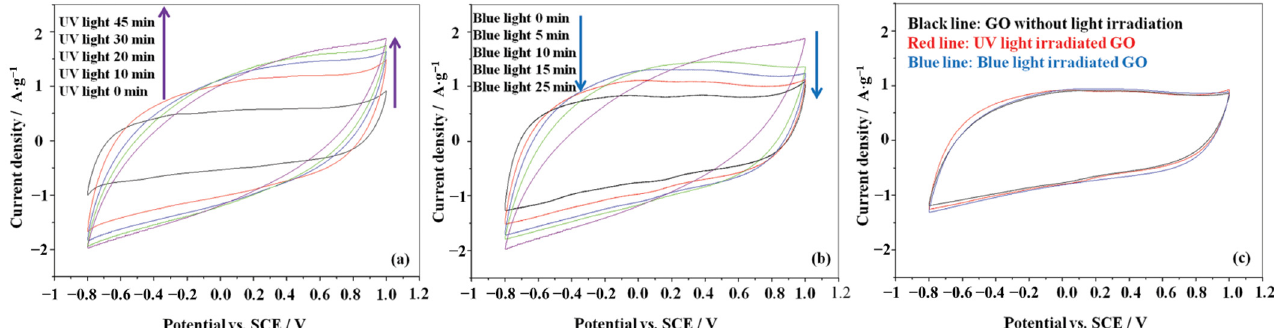
Figure 31. Cyclic voltammograms of ( a ) Azo–GO upon UV irradiation for different times, ( b ) UV-light irradiated Azo–GO upon blue light irradiation for different times, and ( c ) GO after UV light and blue light irradiation in the aqueous solution of 1 M PBS (pH = 7) solution at a potential scan rate of 20 mV ∙ s − 1 . (Reprinted from [114]; published by The Royal Society of Chemistry).